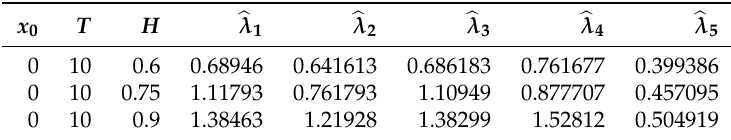
Figure 6. Comparison of (cid:98) λ 1 , (cid:98) λ 2 , (cid:98) λ 3 , (cid:98) λ 4 and (cid:98) λ 5 for 100 trajectories, where H = 0.6, x 0 = 0, T = 10, h = 0.1, σ = 2; the horizontal line shows the true value of the estimated parameter λ = 0.5. Table 2. Root mean square errors of the studied estimators calculated using 100 numerical simulations with λ =